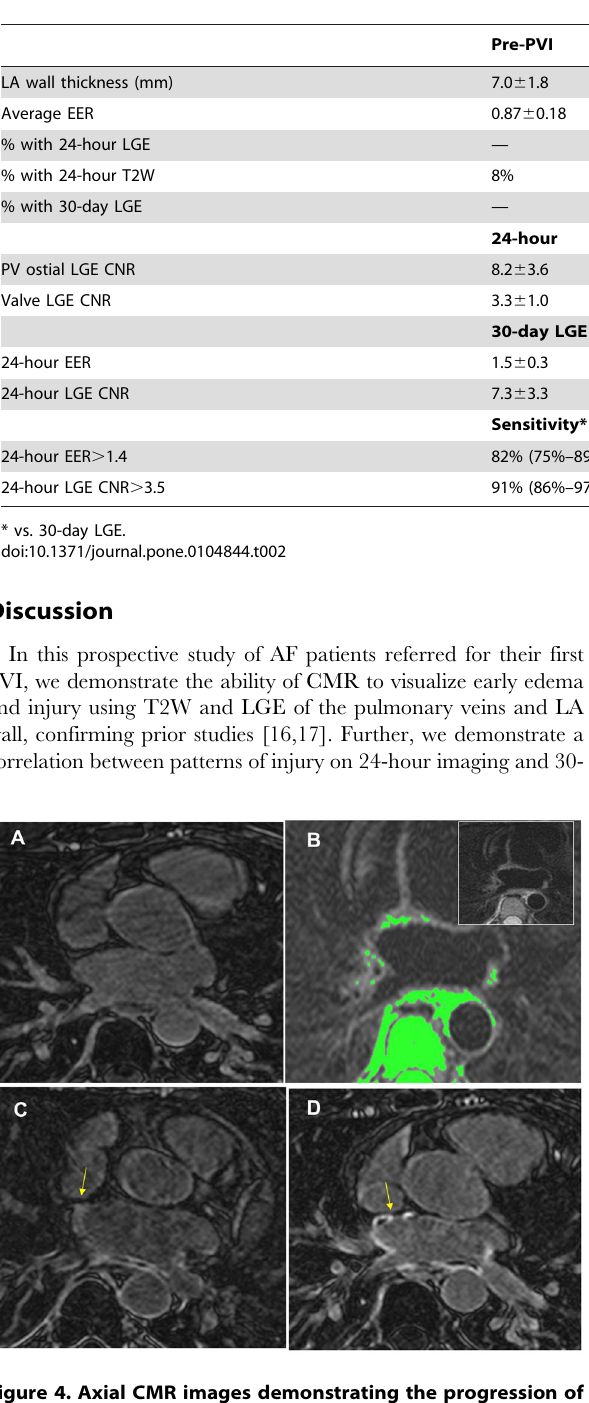
Table 2. Summary of Results.